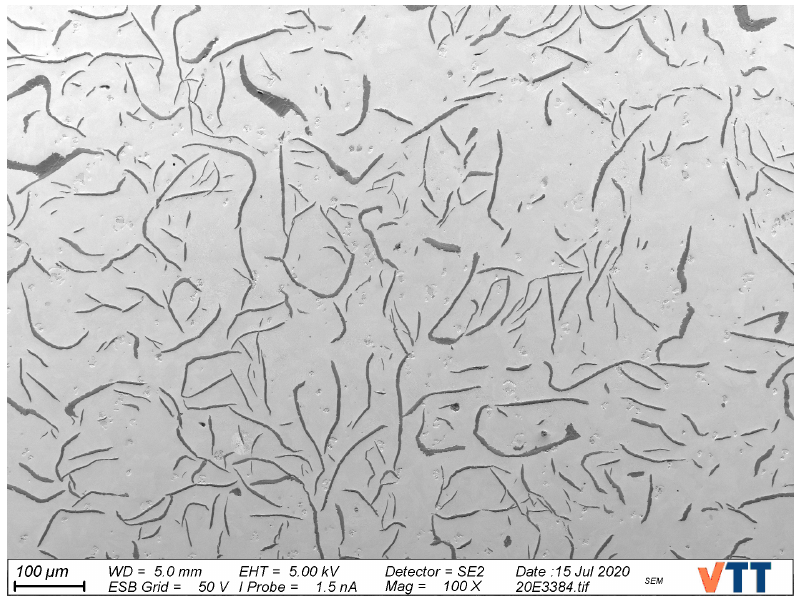
Figure 1. SEM image of typical GJL300 cast iron microstructure.